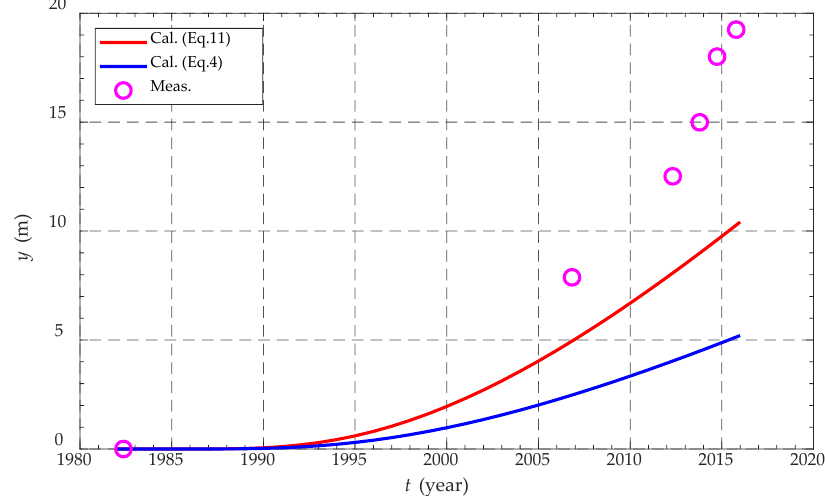
Figure 17. Formation of shoreline position at the boundary (the pier) in Funatsu River.